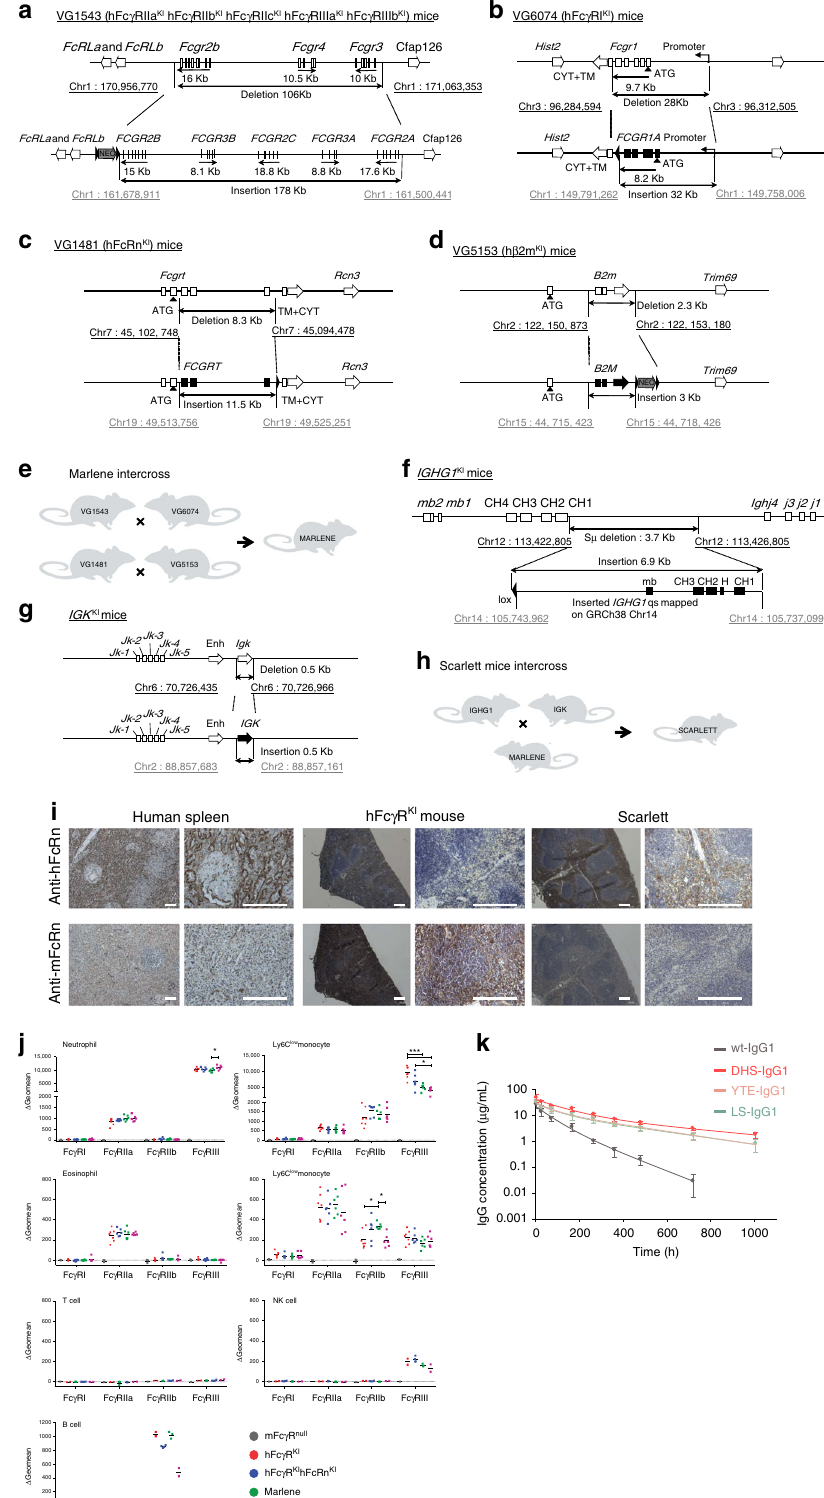
Rituximab, the latter which has already been reported to display signi fi cantly lower CDC activity than wt-Rituximab 18,48 (Fig. 3b, c). Rheumatoid factor (RF) refers to auto-antibodies that bind to the Fc domain of immunoglobulins. The binding of RF to therapeutic antibodies is associated with faster clearance and